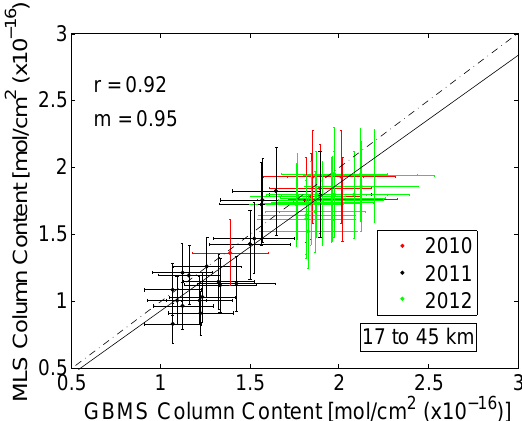
Fig. 8. Same as in Fig. 5, but for HNO 3 column content from 17 to 45km